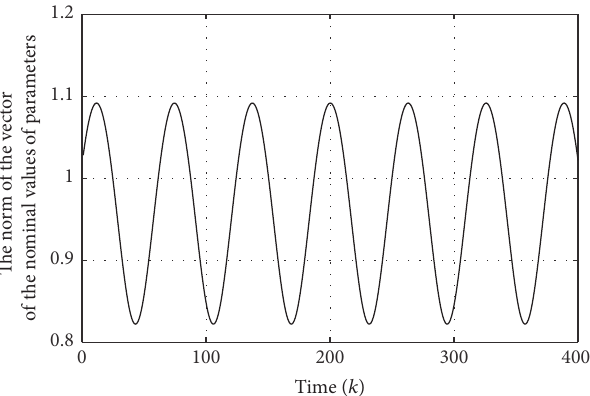
Figure 5: Evolution curve of the norm of the vector of the nominal values of parameters ‖𝜃(𝑘)‖ .